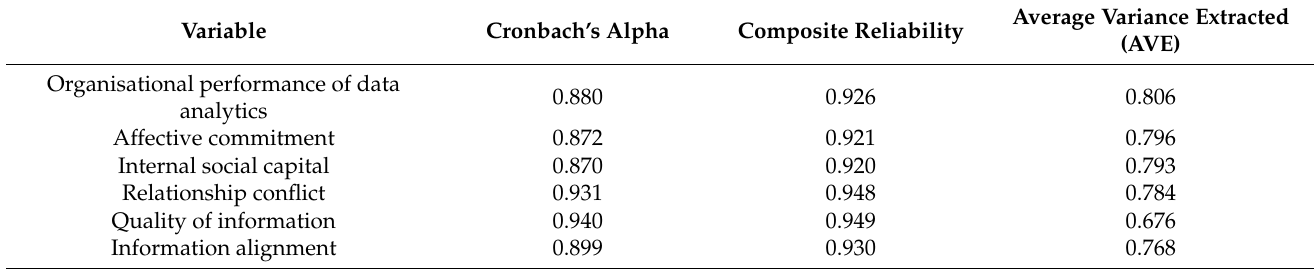
Table 4. Reliability and construct